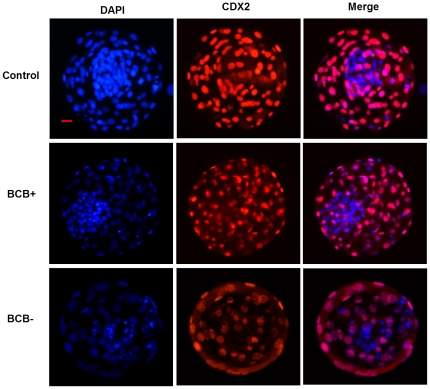
Immunostaining of CDX2.Day 7 SCNT blastocysts developed from control oocytes (control group), BCB+ oocytes (BCB+ group), and BCB− oocytes (BCB− group) were stained with DAPI and CDX2, a marker for trophectoderm. Original magnification was ×200. Bar = 20 µm. n = 35, 36, and 22 in the control, BCB+, and BCB− groups, respectively.